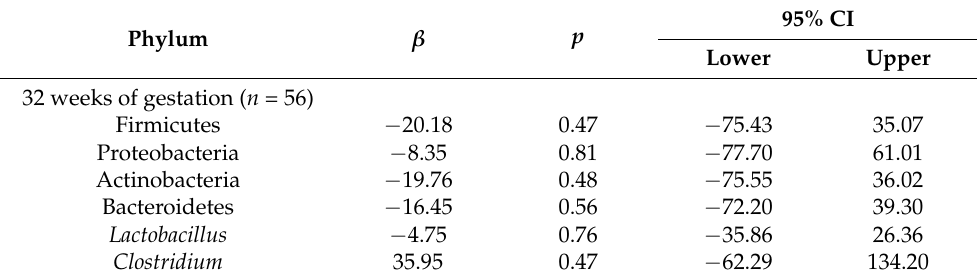
Table A2. Associations between the relative abundance of taxa in maternal feces at 32 weeks of gestation and maternal non-specific serum IgE levels 1